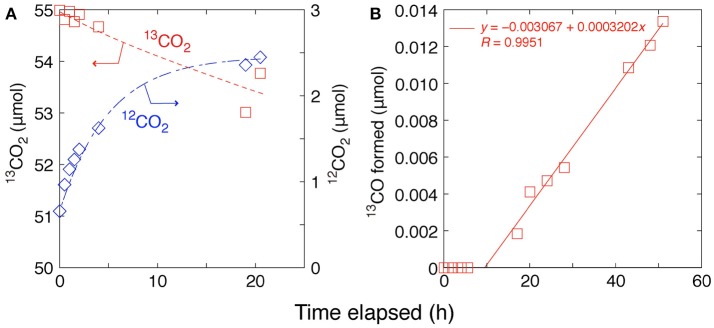
Time courses of (A)
13CO2 (0.68 kPa) photoexchange reaction with preadsorbed 12CO2 on Pd/TiO2 (P25) and (B) photocatalytic reduction test in 13CO2 (2.3 kPa) and H2 (21.7 kPa) on Pd/TiO2 (homemade).